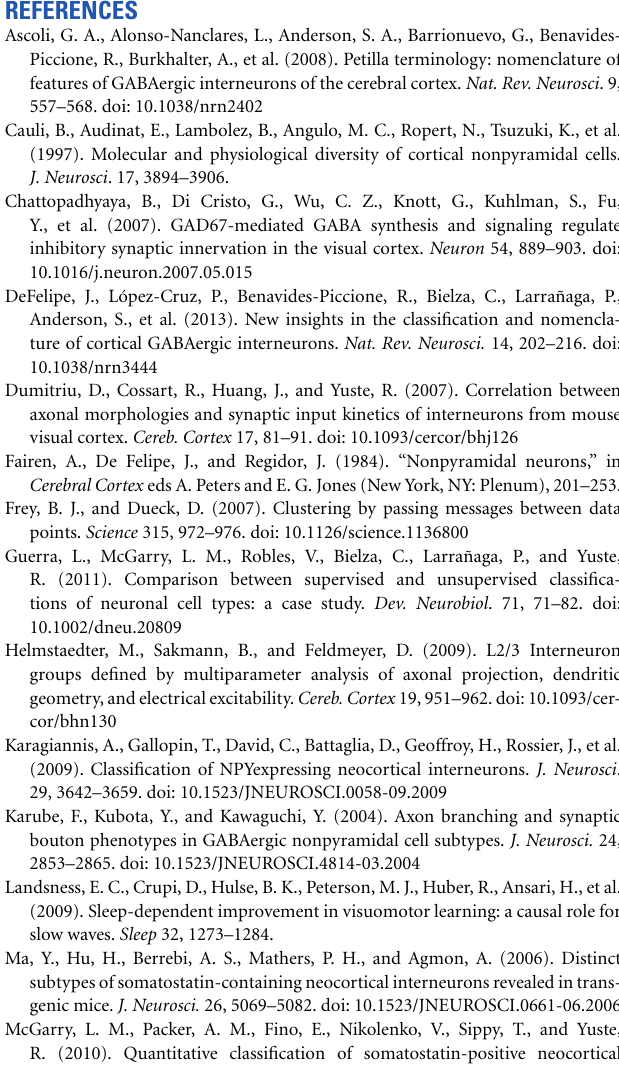
Supplementary Figure 1 | Morphological reconstructions of the neurons used. Ordered according to cell type (ChC, BC, MC, and non-MC). Supplementary Figure 2 | Electrophysiological recordings of the neurons used. Ordered according to cell type (ChC, BC, MC, and non-MC). Supplementary Table 1 | Database of all morphological and electrophysiological